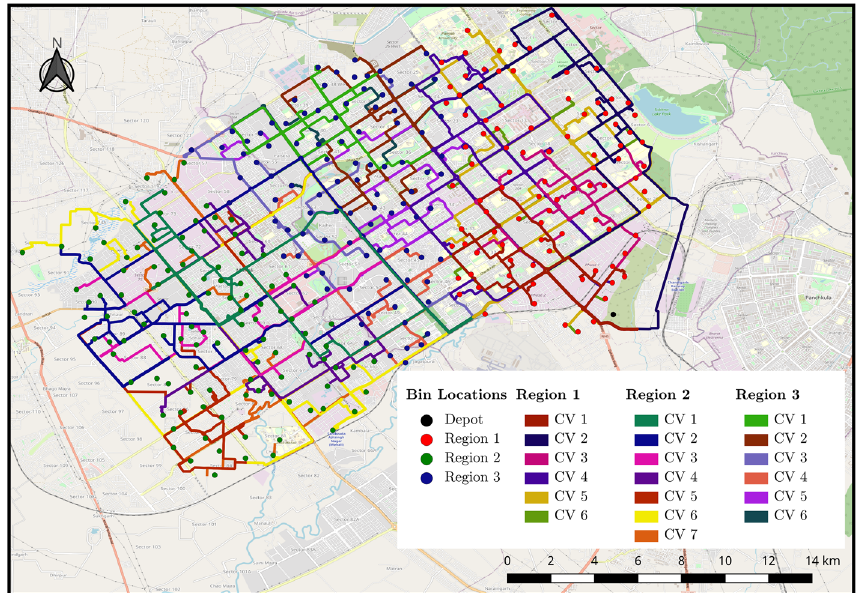
Figure 4. Routes derived for real-time unrestricted